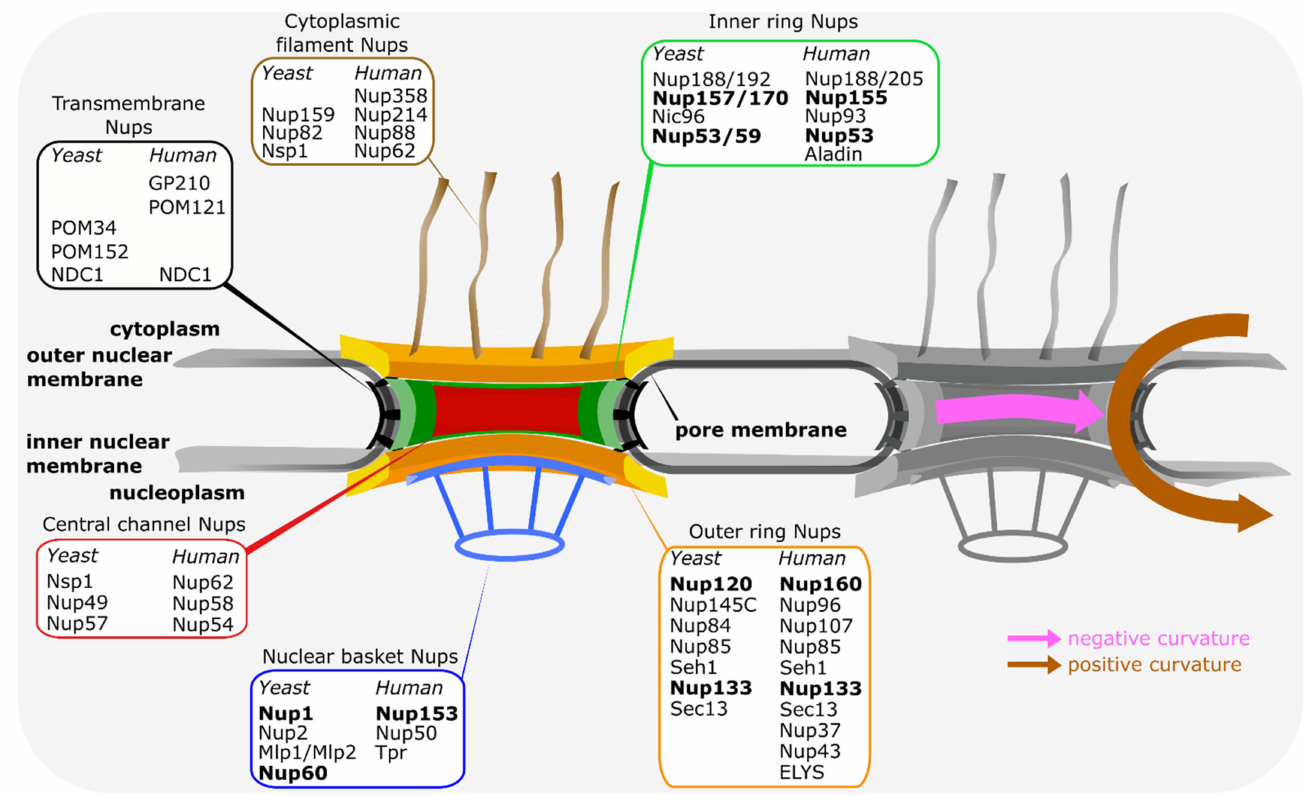
Figure 1. Main features of the vertebrate and budding yeast nuclear pore complexes. Schematic representation of the NPC, highlighting the ring and peripheral structures of the NPC. The inner ring (green) is sandwiched between the two outer rings, i.e., the nucleoplasmic and cytoplasmic rings (both in yellow/orange). From the outer rings, cytoplasmic filaments (brown) and the nuclear basket structure (blue) extend. The inner ring (green) is the main connecting point between the transmembrane nucleoporins (black) and the central channel nucleoporins (red), which are crucial for the transport and exclusion properties of the NPC. The distribution of nucleoporins, referring to the human and budding yeast nomenclature, within the different structural elements is indicated. Nucleoporins, which can directly interact with the pore membrane, are shown in bold. On the right, the positive and negative curvature of the pore membrane is